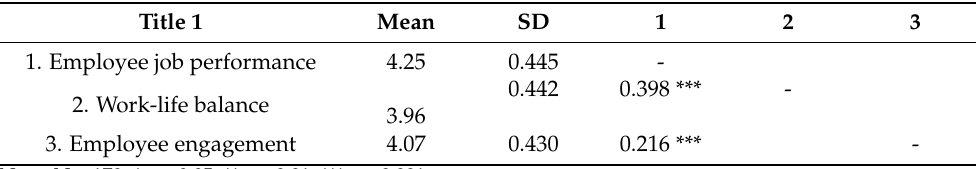
Table 6. Descriptive statistics and correlations among